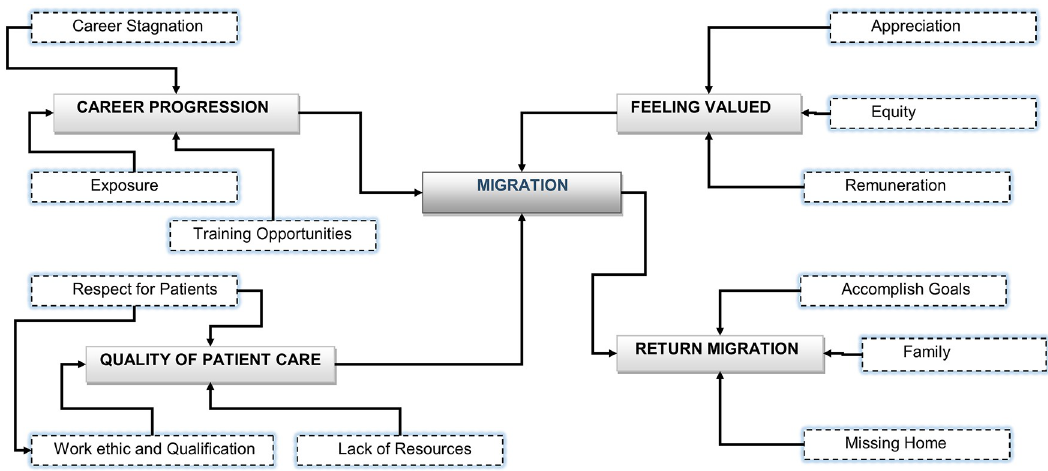
Fig 1. Thematic networks for health worker migration.